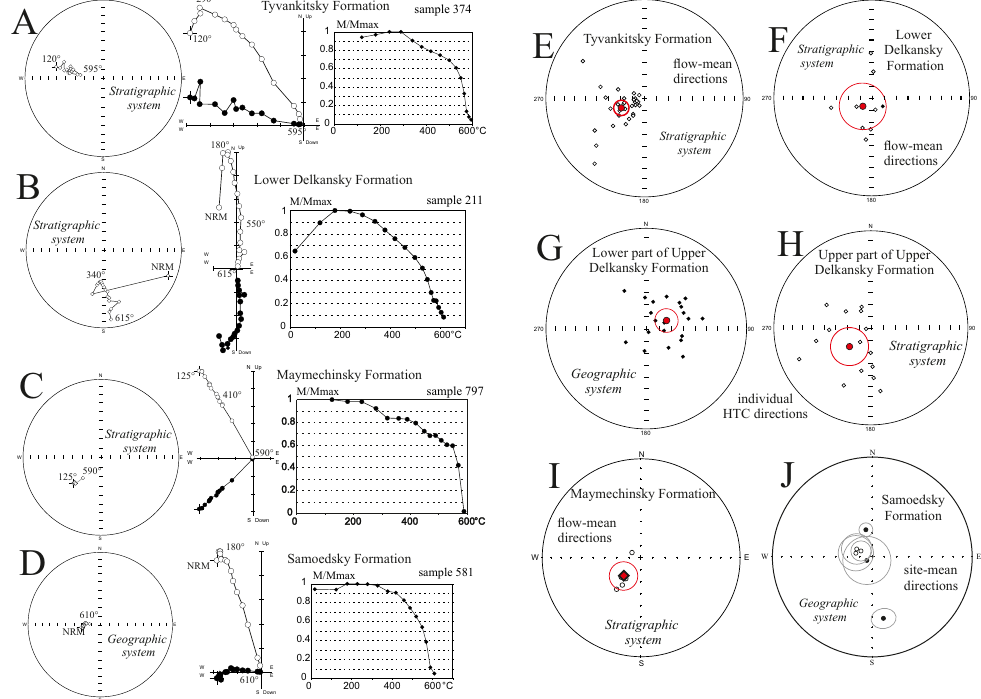
Figure 6. Results of the thermal demagnetization of the Tyvankitsky, Delkansky, Maymechinsky, and Samoedsky formations. ( A – D ) Representative stereoplots, Zijderveld plots and demagnetization paths. ( A )—sample 374, site tv18 , Tyvankitsky formation. ( B )—sample 211, location 5, Lower Delkansky Formation. ( C )—sample 797, site mm5 , Maymechinsky Formation. ( D )—sample 581, site sm4 , Samoedsky Formation. E-J. Distribution of paleomagnetic directions. ( E )—Tyvankitsky Formation, site-mean directions, stratigraphic coordinate system. ( F )—Lower Delkansky Formation, site-mean directions, stratigraphic coordinate system. ( G )—lower part of the Upper Delkansky Formation, geographic coordinate system. ( H )—upper part of the Upper Delkansky Formation, geographic coordinate system. ( I )—Maymechinsky Formation, site-mean directions, stratigraphic coordinate system. ( J )—Samoedsky Formation, site-mean directions geographic coordinate system. Closed (open) circles indicate lower (upper)